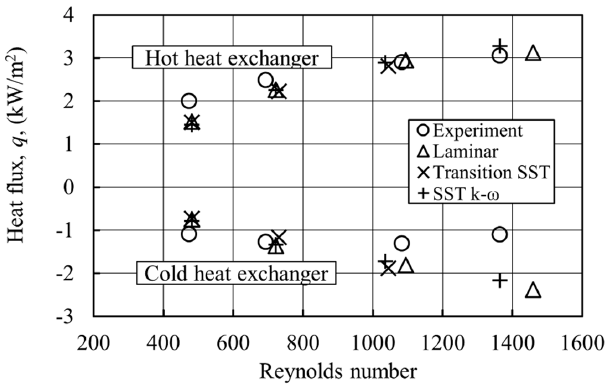
Figure 19. Heat fluxes at cold and hot heat exchangers: comparison between numerical and experimental results.